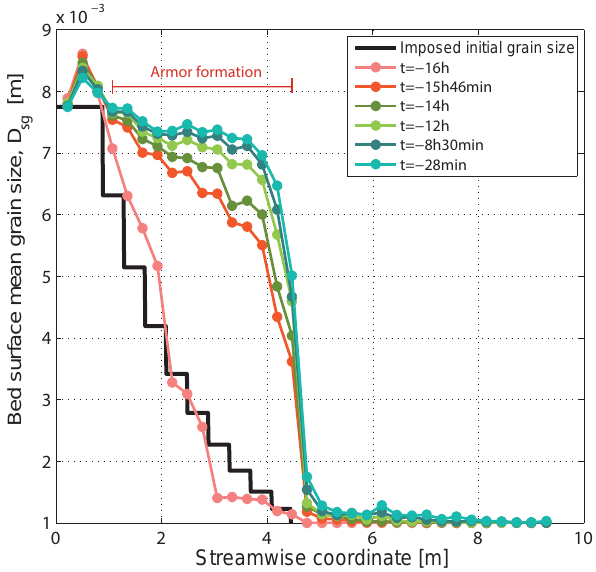
Figure 5. Imposed and measured geometric mean grain size of the bed surface sediment at various times for Experiment T 1